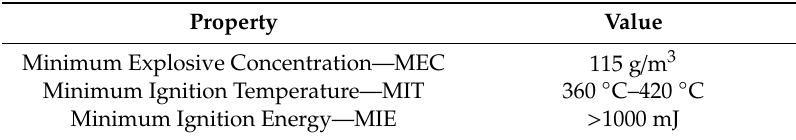
Table 4. Explosive properties of samples of granulated sugar collected from the Port Wentworth facility